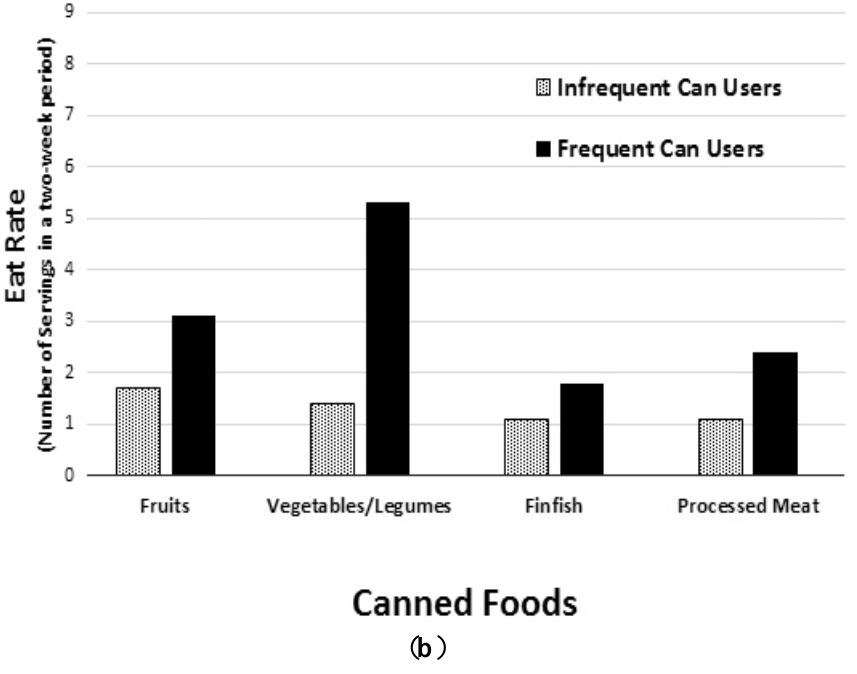
Figure 2. Fresh ( a ) and canned food ( b ) Eat Rate ( i.e. , average number of food category eating occasions over a two-week period) among Frequent and Infrequent Canned Food Users (FCU and ICU). Proportion of infrequent ( n = 2732) and frequent ( n = 2584) canned food users Eat Rate. Data from the NPD Group’s National Eating Trends (cid:114) intake diary panel 2011–2013 and Nutrient Intake databases. Statistical confidence level set at 95% for two-tailed t test. p -Value < 0.025% considered